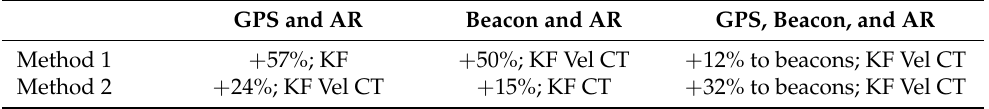
Table 14. MSE improvement of the best Kalman filters. GPS and AR Beacon and AR GPS, Beacon, and AR Method 1